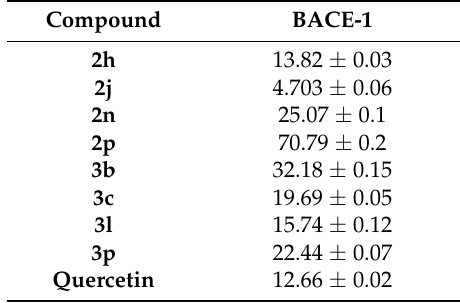
Table 4. IC 50 values for the inhibitory effect of 2h , 2j , 2n , 2p , 3b , 3c , 3l , 3p against BACE-1